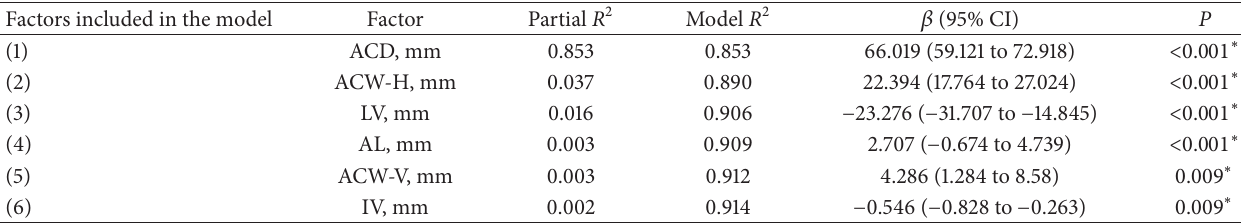
Table 3: Stepwise multiple linear regression analysis of factors associated with anterior chamber volume.